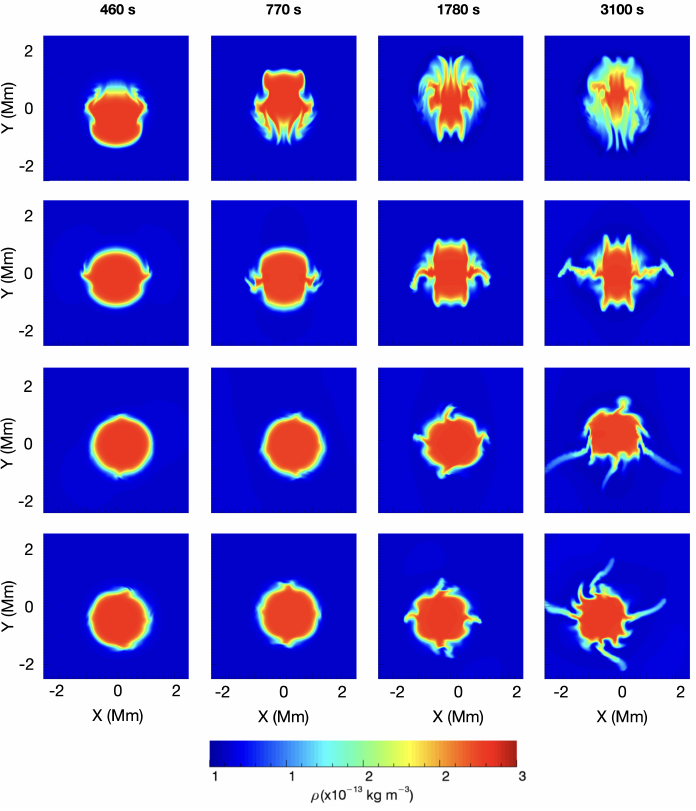
Figure 3. Evolution of the density profile at the loop apex ( z = 100 Mm) for the four simulations: the ResUni, BbUni, ResMulti and BbMulti cases ( top to bottom ) for different times: 460 s, 770 s, 1780 s and 3100 s, as indicated ( left to right ). See text for